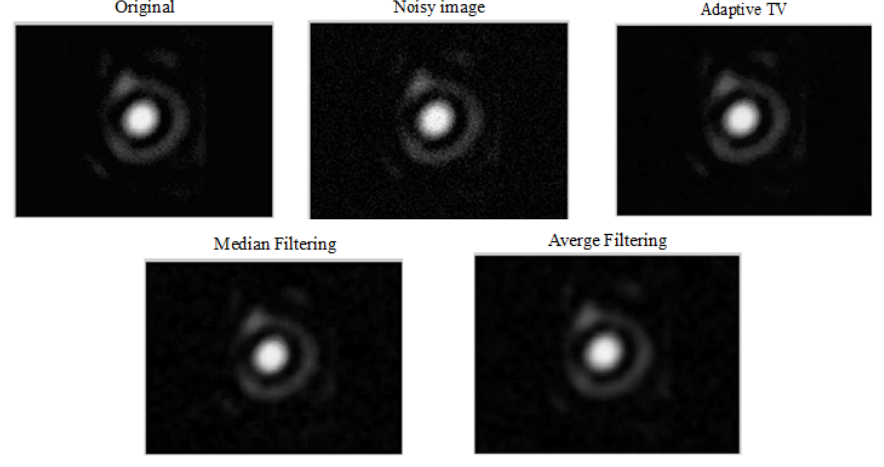
Fig. 3 Results of our algorithm.